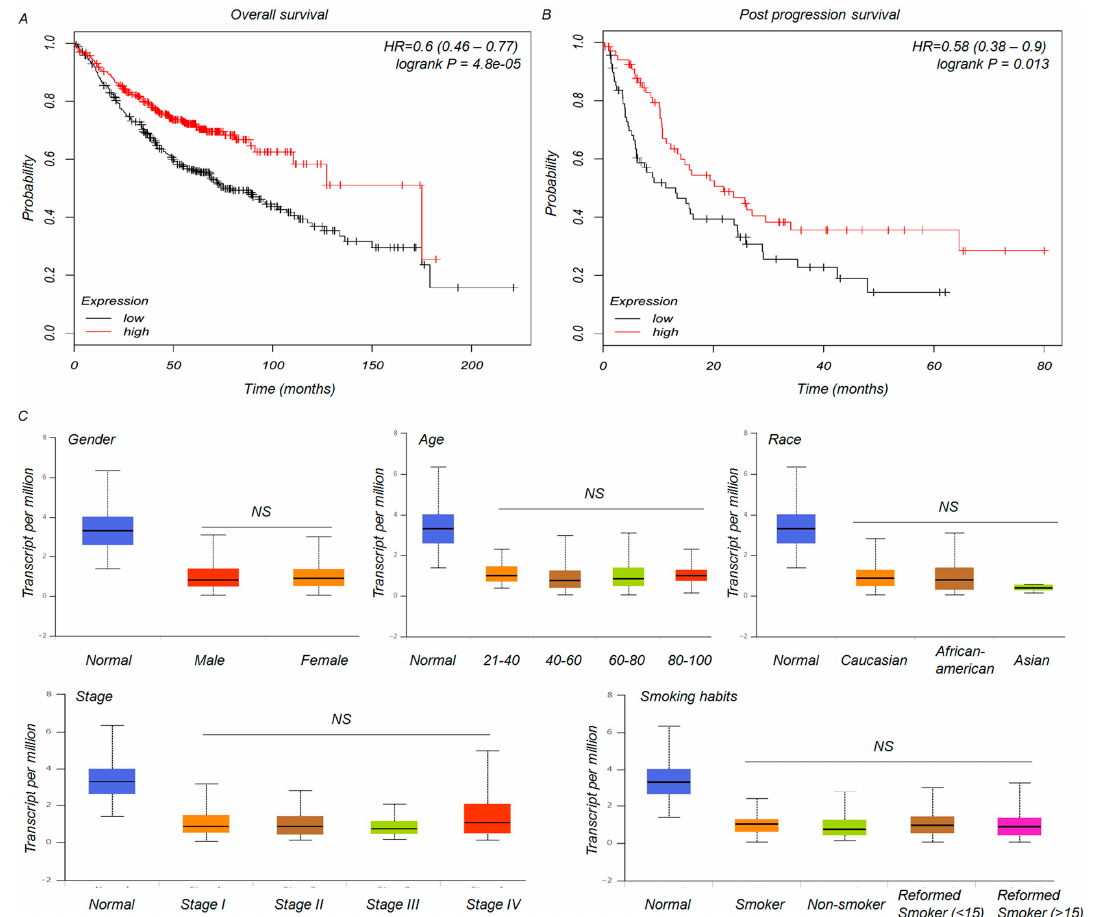
Figure 3. The association between SNCA expression and clinical characteristics of ADC patients. ( A , B ) Kaplan-Meier analysis of overall survival (OS) and post-progression survival time (PPS) in ADC patients based on SNCA expression. ( C ) The cancer genome atlas (TCGA) clinical data from the UALCAN web tool were used to categorize ADC patient characteristics according to their expression levels of SNCA , such as gender, age, race, etc.